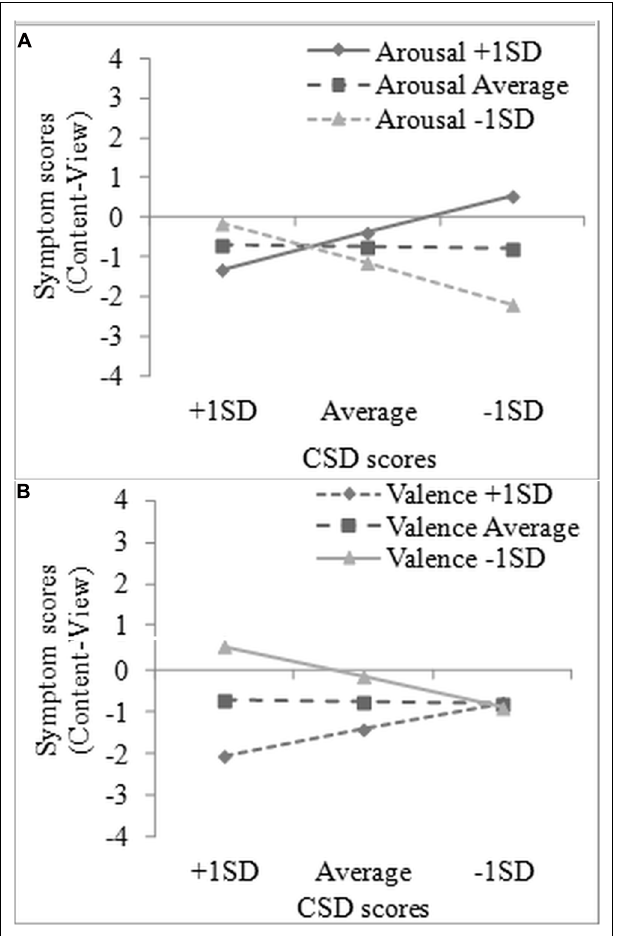
FIGURE 4 | Interaction effects predicting content labeling effect on symptom reports: (A) habitual symptom reporting × arousal ratings and (B) habitual symptom reporting × valence ratings. CSD = Checklist for Symptoms in Daily